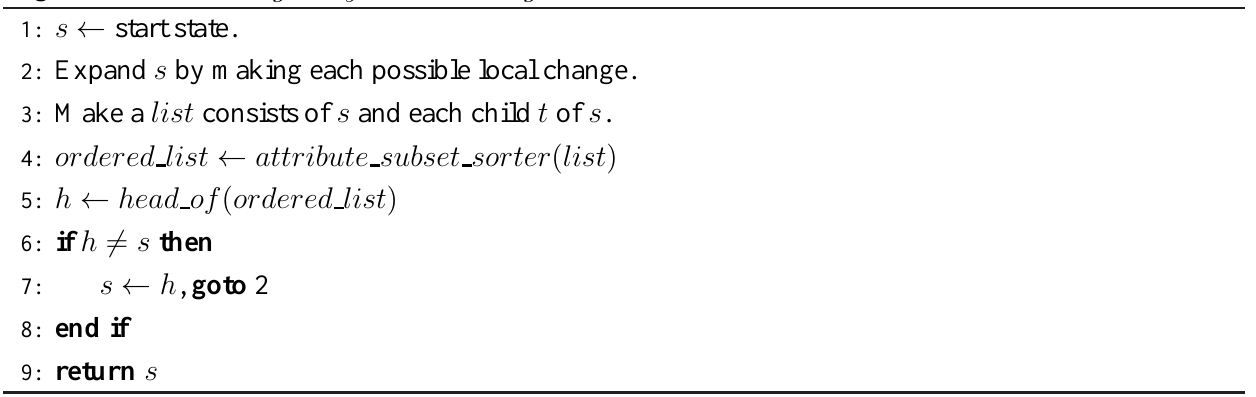
Algorithm 2 ordinal greedy hill climbing